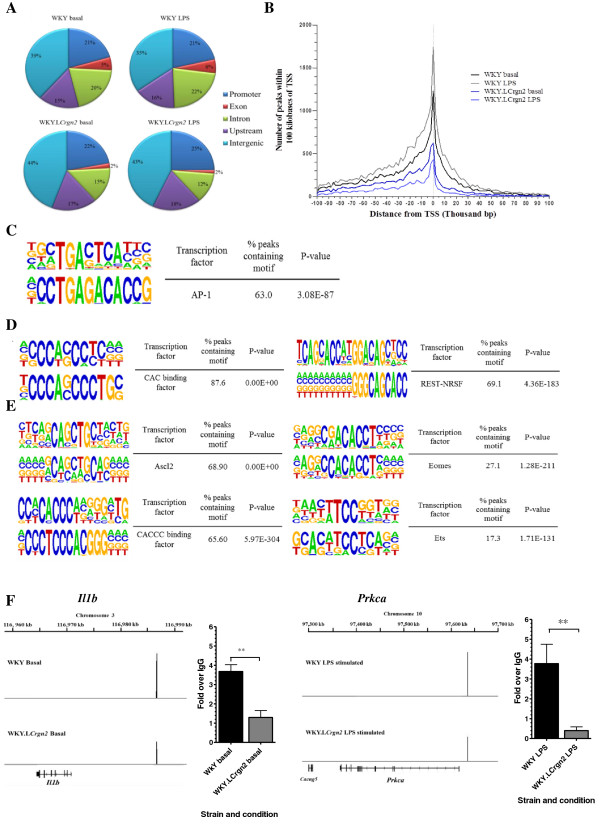
Genetically determined differences in Jund expression alter the JunD cistrome and identifies primary JunD targets. (A) Distribution of JunD-peaks relative to transcriptional start sites (TSS) of Ensembl genes. Promoter region defined as 20 kilobases (kb) upstream of the TSS, upstream region between 10kb and 50kb upstream from TSS. (B) Occurrence of peaks within 100 kilobases of the TSS. (C) Twelve base pair AP-1 motif identified by de novo motif analysis present in 63% peaks. De novo motif analysis using HOMER identified two de novo motifs in basal WKY BMDMs (D) and four motifs in LPS stimulated WKY BMDMs (E). The de novo motif identified is displayed on the bottom of each the pair of motifs, the matched consensus motif for a transcription factor on the top. (F) Il1b and Prkca confirmed as primary JunD targets by qPCR validation. The aligned reads comprising peak passing the posterior probability threshold of 0.9 for each JunD-bound gene in the WKY strain in the LPS stimulated state for l1b and the basal state for Prkca are shown in genome browser views along with the peak in the WKY.LCrgn2 strain. Samples from WKY and WKY.LCrgn2 strains were amplified using three biological replicates with three technical replicates per sample. Results expressed as mean fold change over IgG. *P<0.05; **P<0.01; using a one-tailed unpaired t-test to detect statistically significant differences between the strain and condition pairs. Error bars represent standard error of the mean.